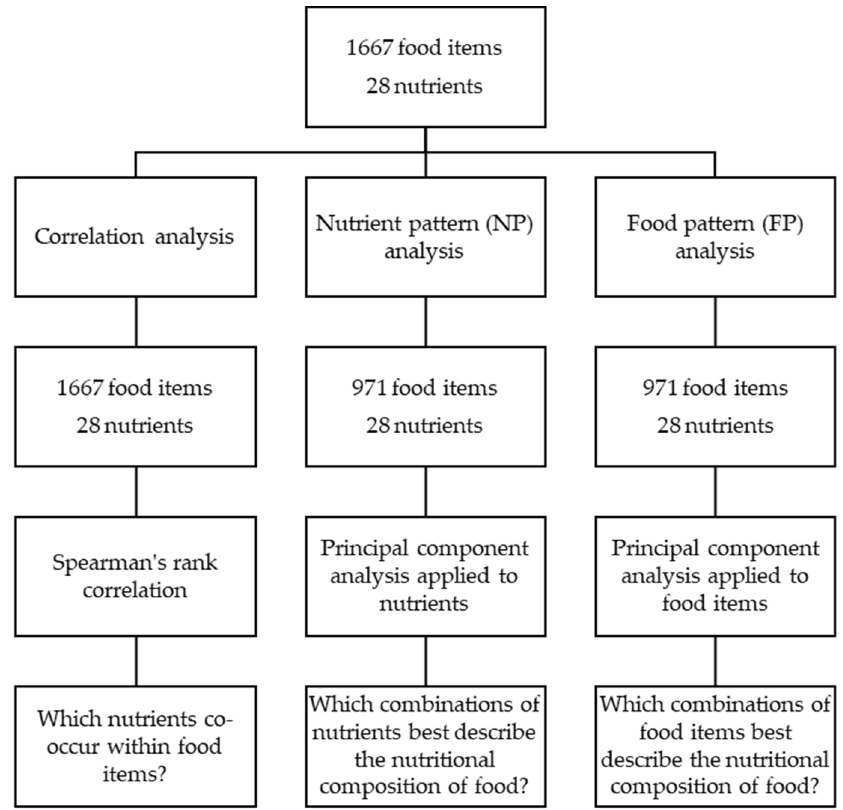
Figure 1. Flow chart of methodology and rationale.